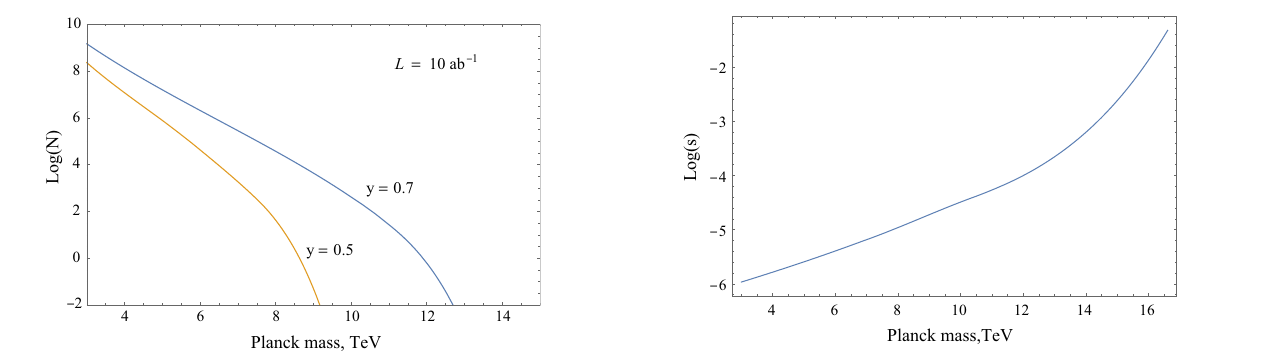
Fig. 3 The fraction of the neutral black holes produced at the future 100 TeV collider which are trapped inside the Earth (theories with 6